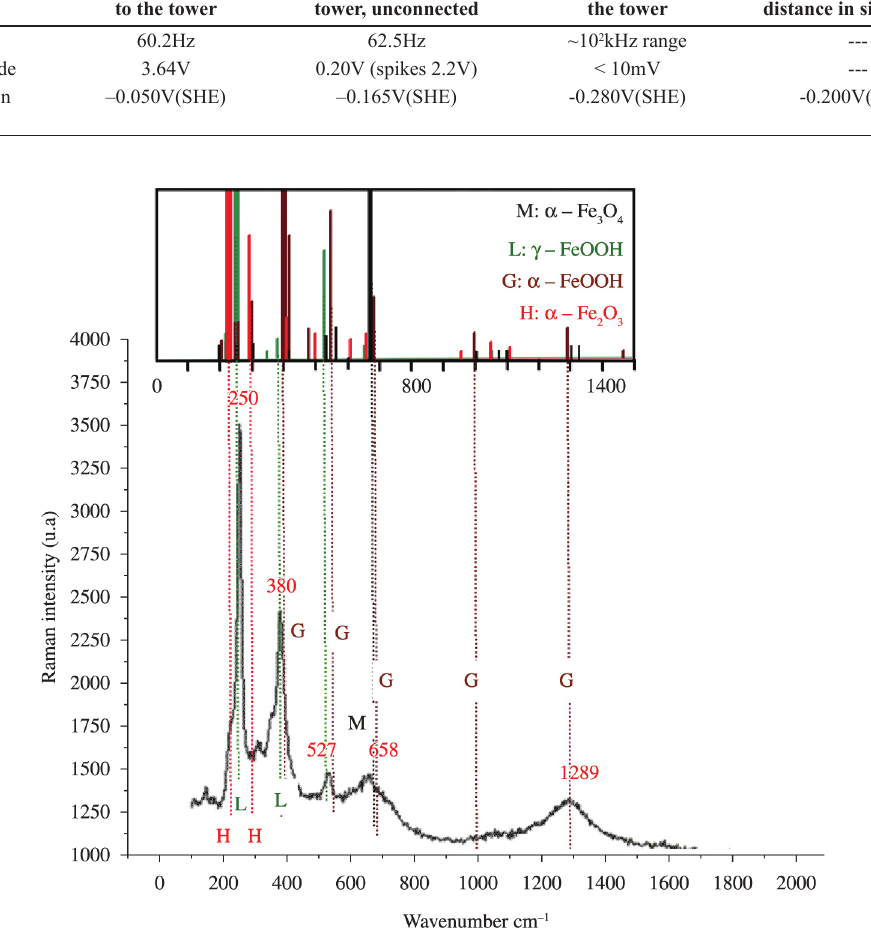
Figure 7. Raman spectrum of the corrosion products for AISI 1020 exposed during 64 days connected to the power line tower. Insert: Schematic normalized Raman spectra of lepidocrocite (L), goethite (G), magnetite (M) and hematite